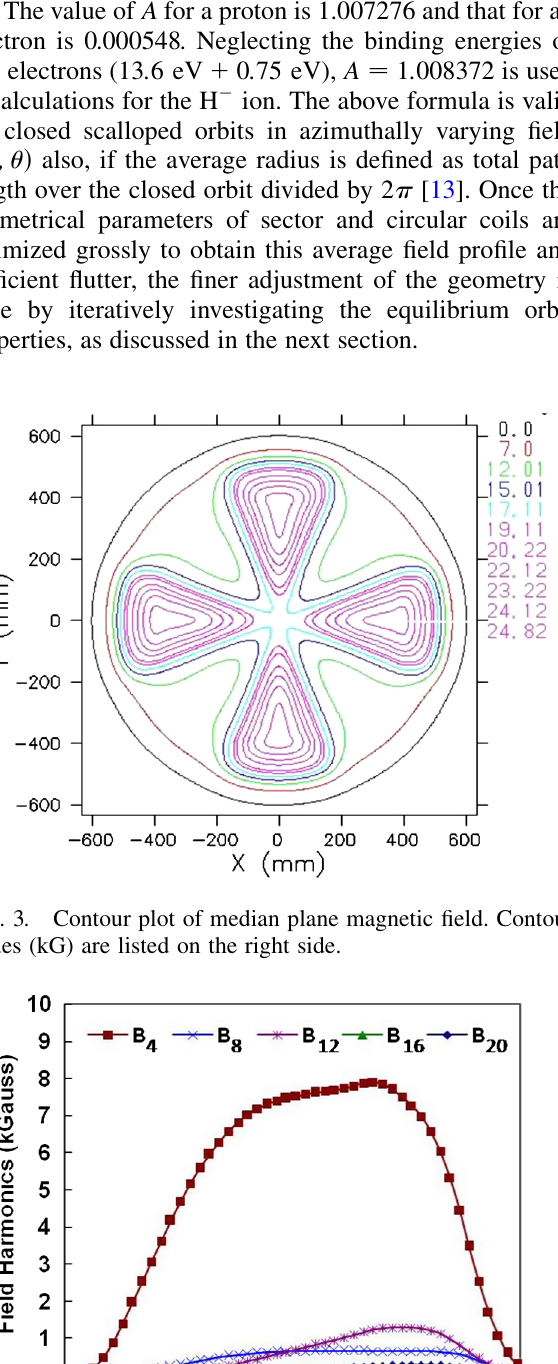
and B ensure vertical focusing 4 8